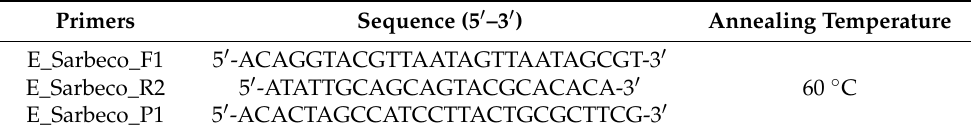
Table 1. Primer and probe sequences.